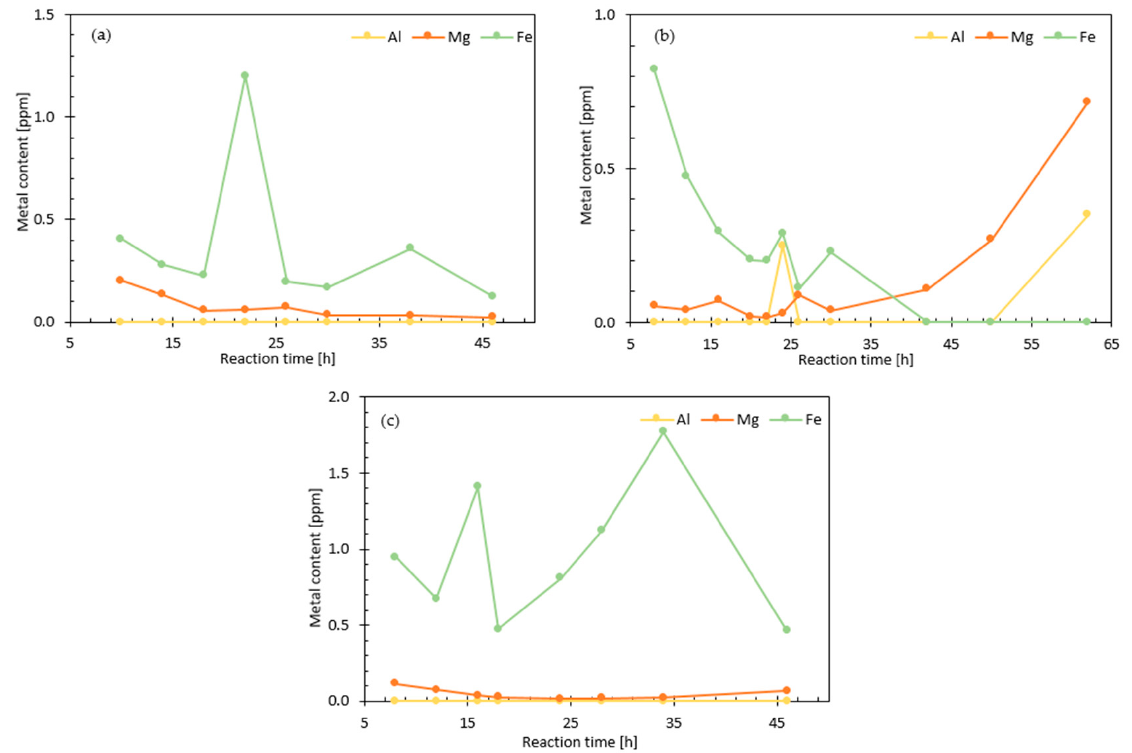
Figure 5. Metal content in products from aldol cond., ( a ) 1:2.5 (F:Ac); ( b ) 1:2.5 with 5 wt.% H 2 O; ( c ) 1:2.5 with 5 wt.% H 2 O over regenerated catalyst. Tests were performed in a continuous-flow reactor at constant temperature 40 °C and pressure 1 MPa, flow of feedstock 10 g/h.